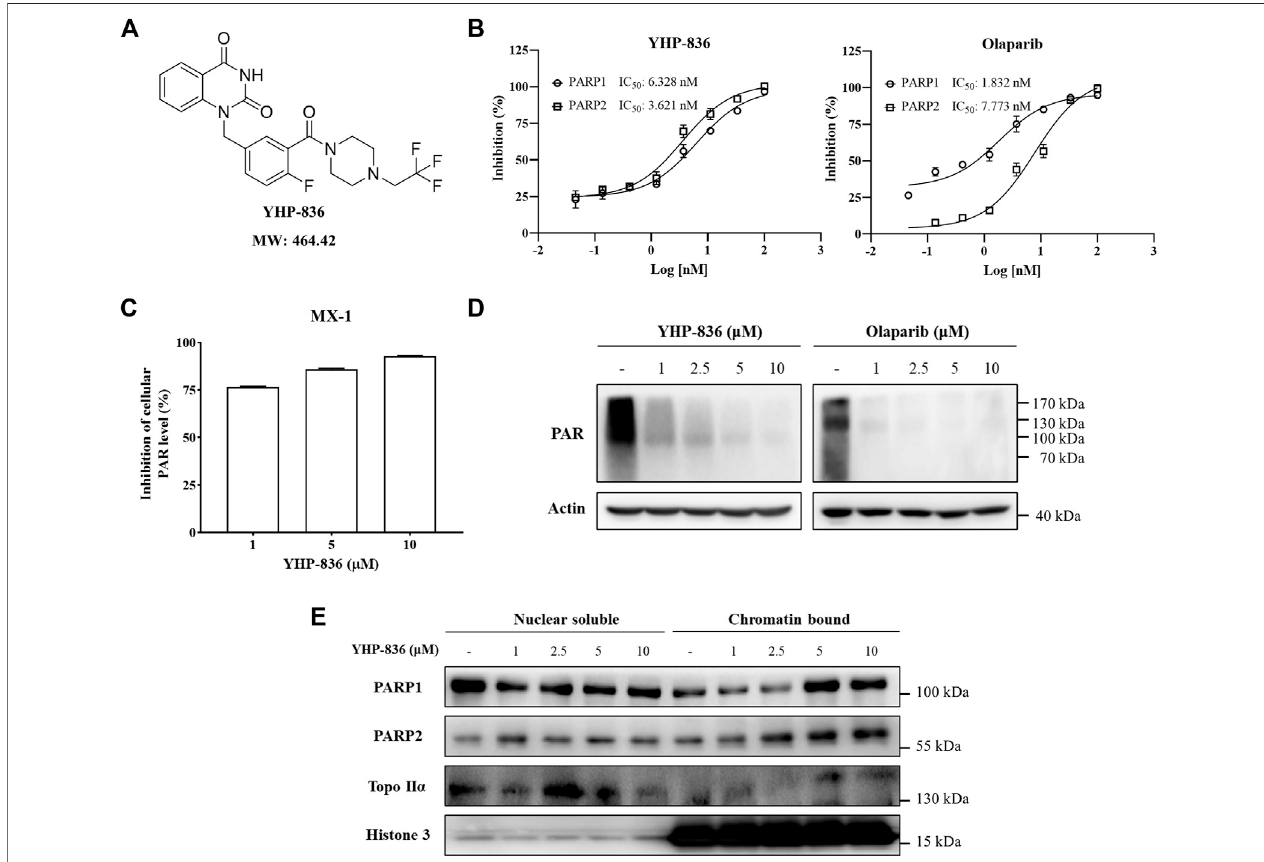
FIGURE 1 | The structure of YHP-836 and its activity. (A) The chemical structure of YHP-836. (B) The inhibitory effect of YHP-836 and olaparib on PARP1 and PARP2. (C) The activity of YHP-836 against intracellular PAR levels in MX-1 cells. MX-1 cells were treated with indicated concentrations of YHP-836 for 12 h. (D) The inhibitoryeffectofYHP-836andolaparibonPARlevelsinMX-1cellsbyimmunoblotting.MX-1cellswereexposedtoindicatedconcentrationsofYHP-836orolaparibfor 24 h. (E) PARP DNA-trapping ability of YHP-836. MX-1 cells were incubated with indicated concentrations of YHP-836 for 24